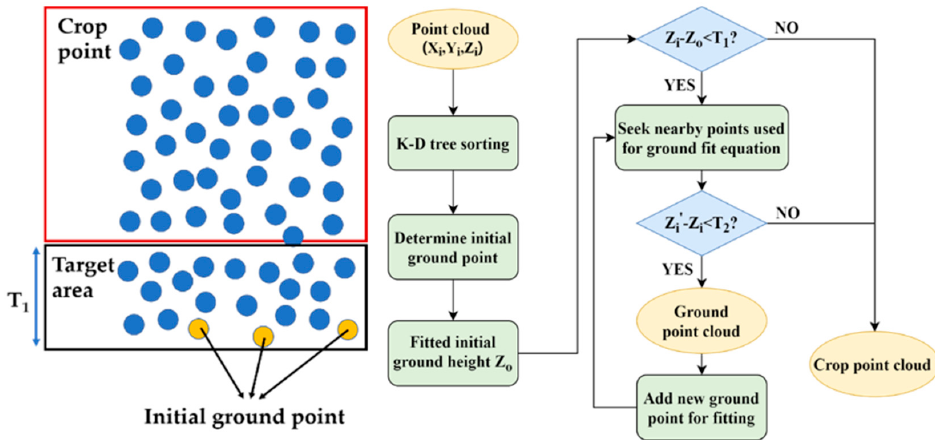
Figure 6. Flow chart of moving surface classification.